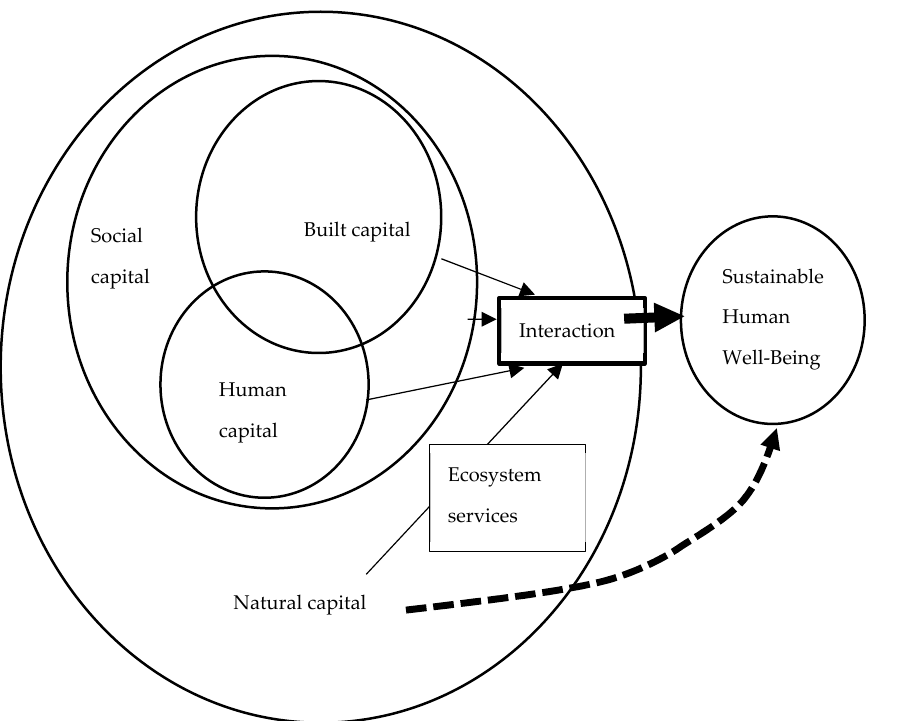
Figure 1. Interaction between social capital, built capital, human capital, and natural capital to con ‐ tribute to social and human well ‐ being. Source: Adapted from [56].